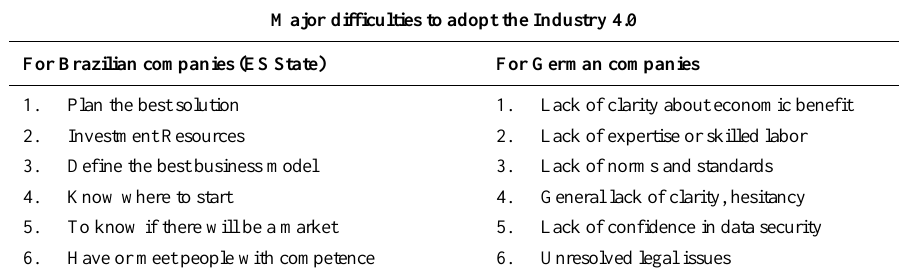
Table 2. Major difficulties for adoption of Industry 4.0, by importance (Source: VDMA to German companies [7]). Major difficulties to adopt the Industry